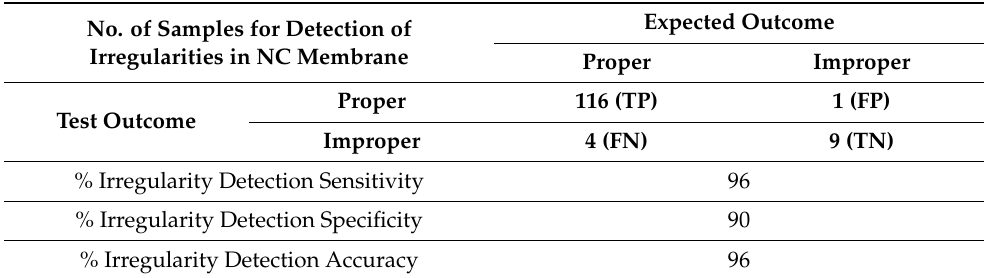
Table 4. Detection of abnormalities in NC